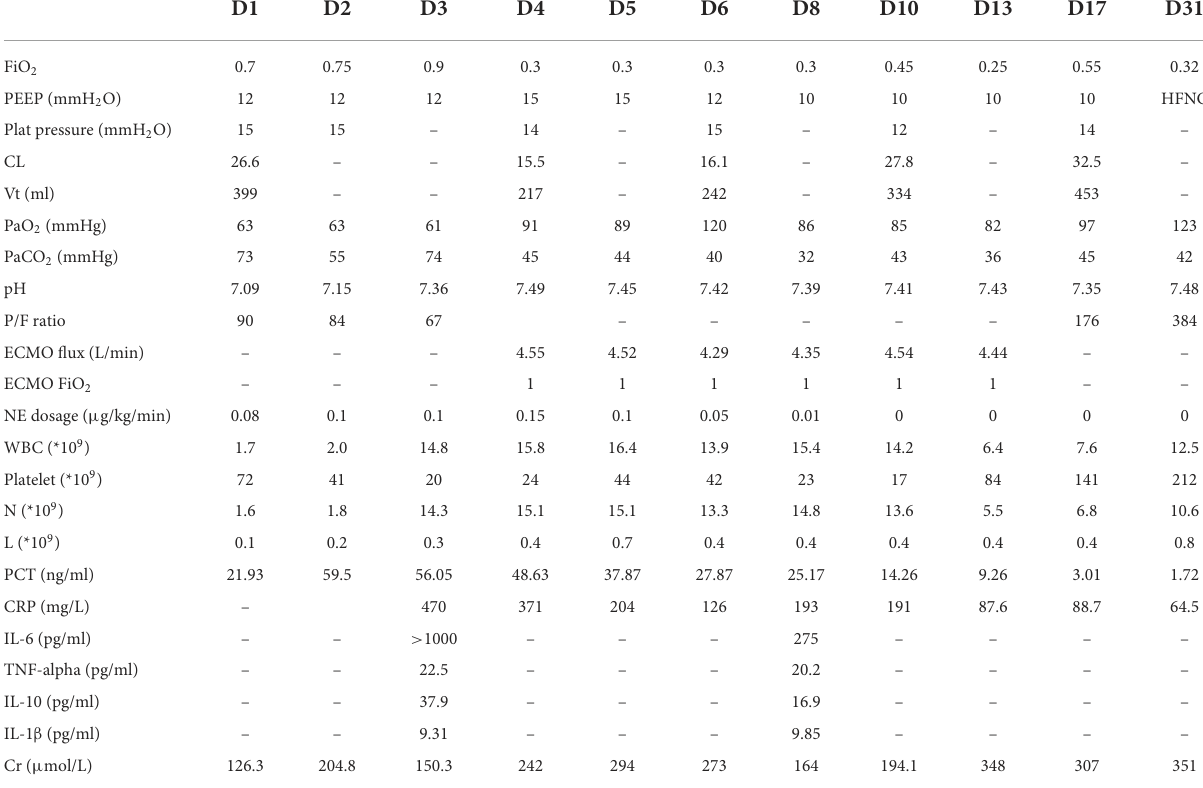
TABLE 1 ECMO, ventilator parameters, inflammatory markers, and renal function of the